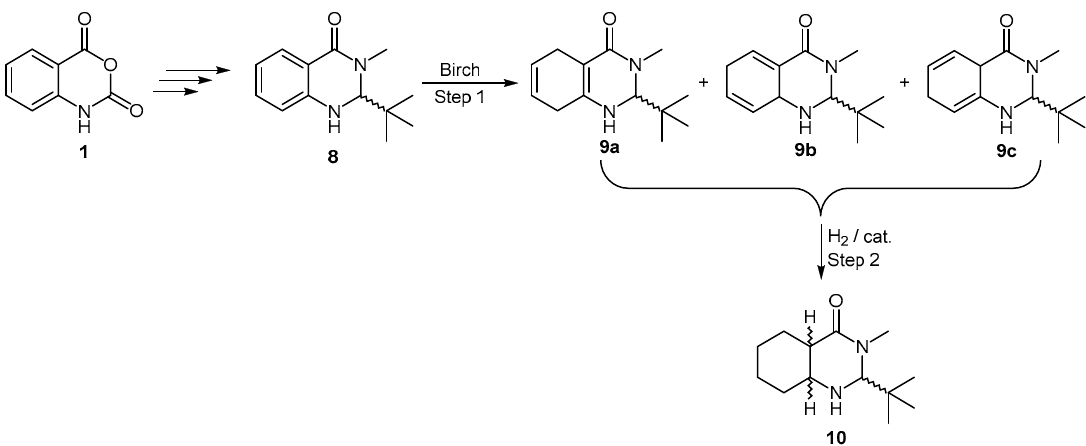
Scheme 3. Design of the total reduction of the aromatic ring of quinazolinone 8 in